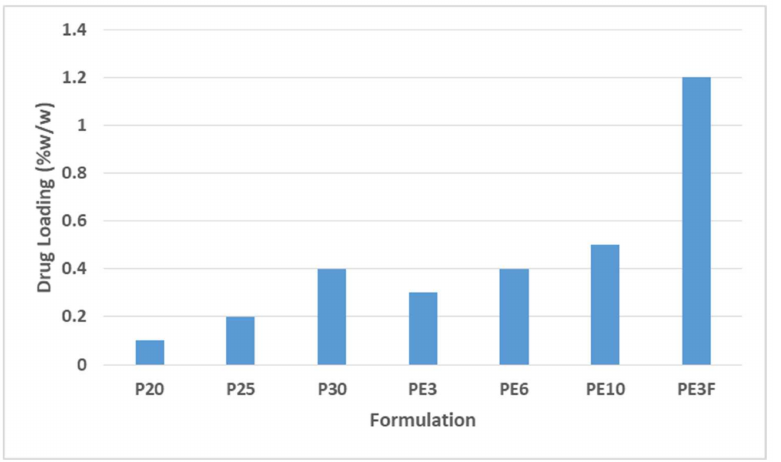
Figure 4. Saturation limit of terbinafine HCL loading in different formulations. P20, P25, P30 (simple P407 aqueous gels with increasing concentration of P407) and PE3, PE6, PE10 (gels containing 27% P407 with increasing concentration of ethanol) were prepared with simple cold method whereas PE3F is optimized formulation (27.32% of P407, 3.18% of ethanol and 4.76% of glycolic acid) prepared with film hydration method.